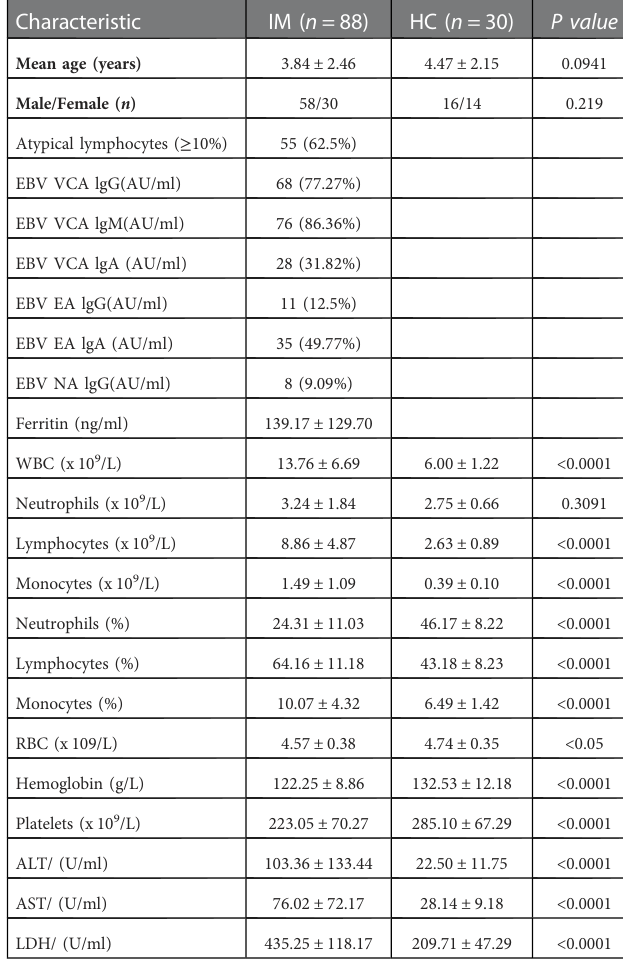
TABLE 1 Basic characteristics of pediatric patients with infectious